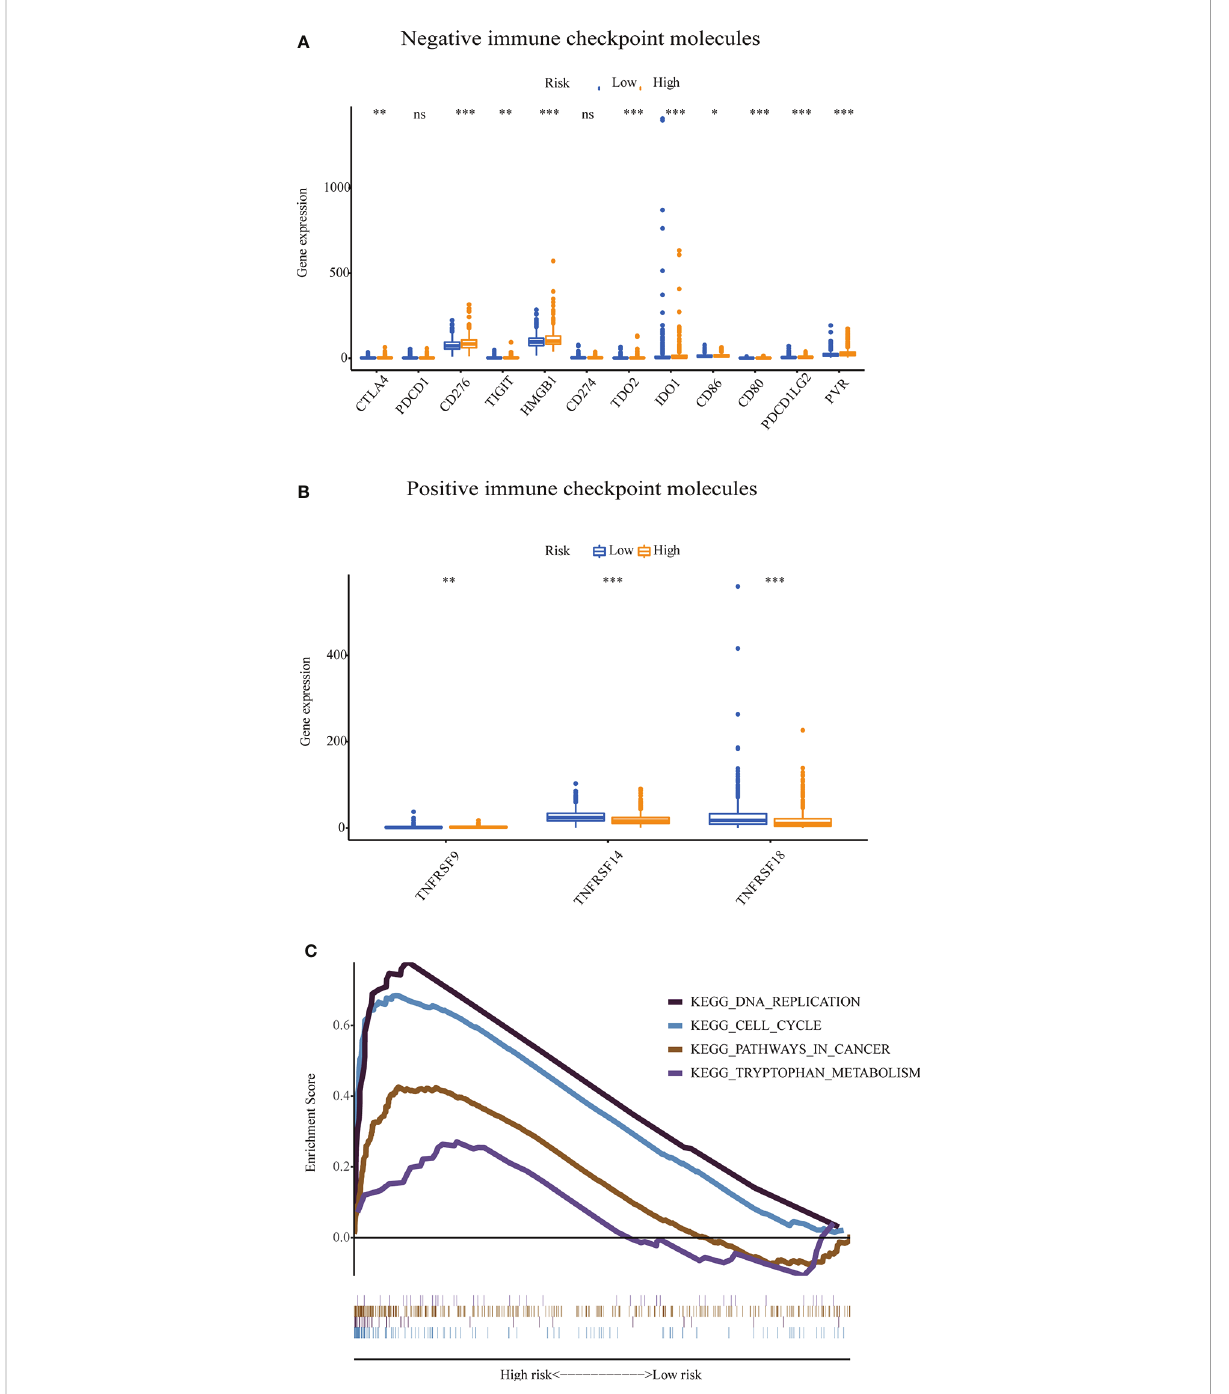
FIGURE 9 The expression level of some immune checkpoint molecules and representative transcriptome traits of biological function between the patients in the high-risk group and low-risk group. (A) The negative immune checkpoint molecules. (B) The positive immune checkpoint molecules. (C) Representative transcriptome traits of biological function in multiple GSEAs of patients in the high-risk group and low-risk group.GSEA, gene set enrichment analysis. *p < 0.05, **p < 0.01, ***p < 0.001, ns, no signi fi